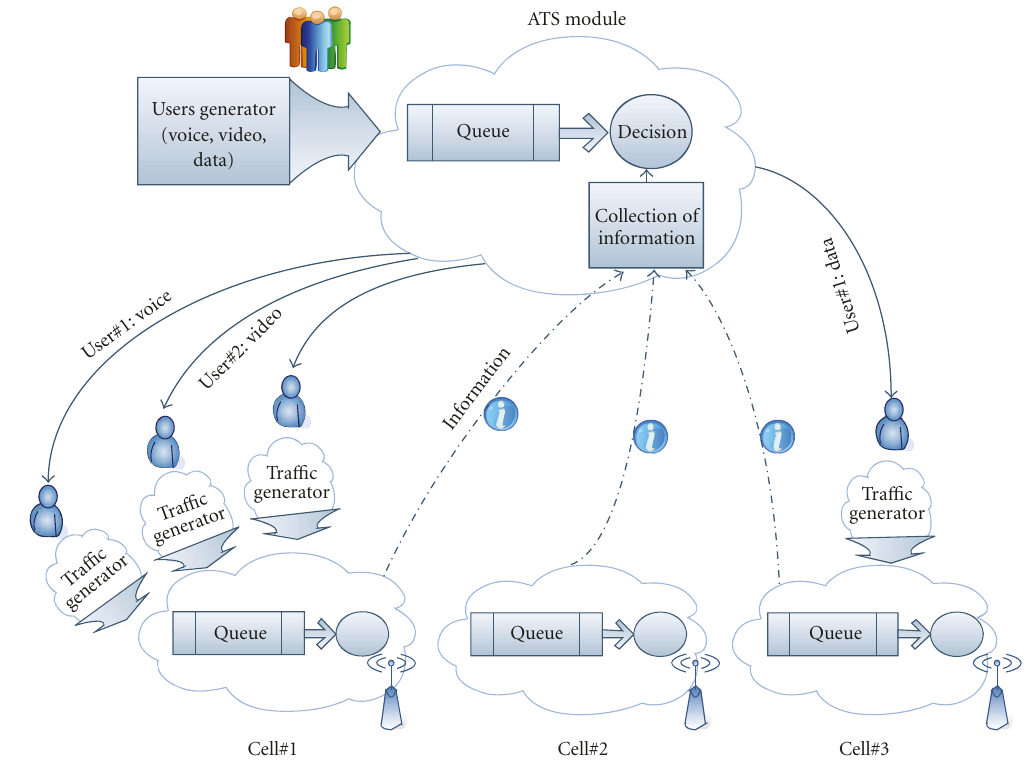
Figure 3: General schema representing the di ff erent parts of the simulator.